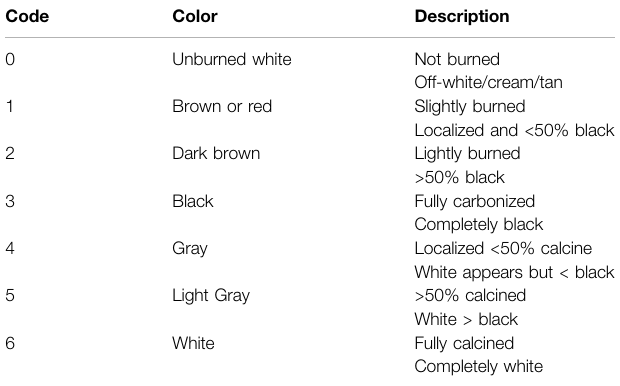
TABLE 1 | Burn color code and descriptions by criteria.